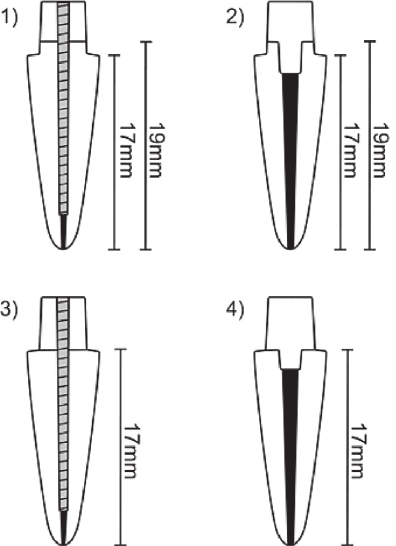
Figure 1- Specimen designs in the different groups: (1) with Fp and with post; (2) with Fp and without post; (3) without Fp and with post; and (4) without Fp and with post